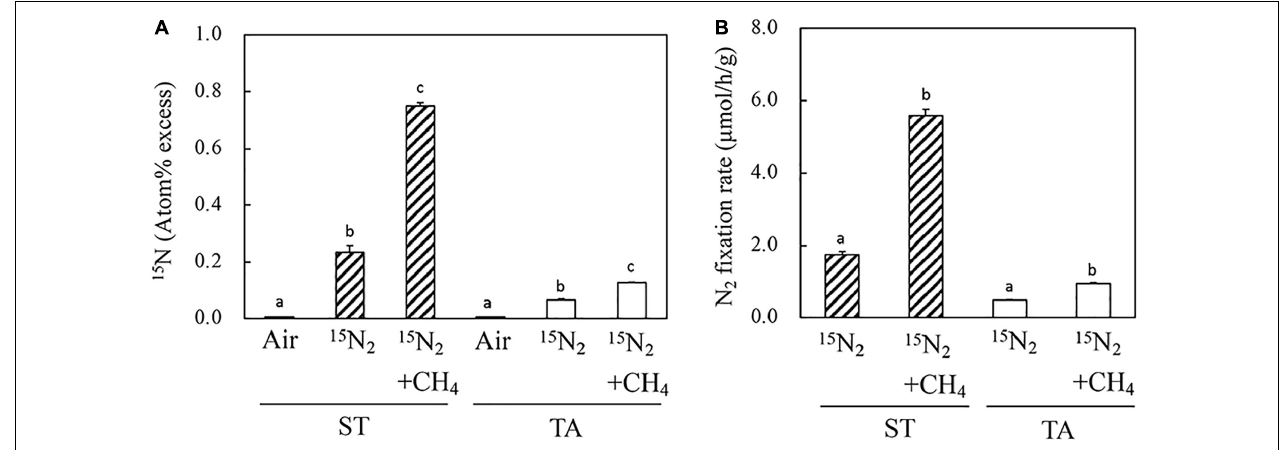
FIGURE 2 | 15 N incorporation from 15 N 2 into roots (A) and the N 2 fixation rate (B) of wetland-grown macrophytes in the presence and absence of 5% CH 4 . Air and 15 N 2 , 15 N concentrations before and after root exposure to a gas mixture of 32% (v/v) 15 N 2 and 5% (v/v) O 2 in argon balance, respectively. +CH 4 , addition of 5% (v/v)